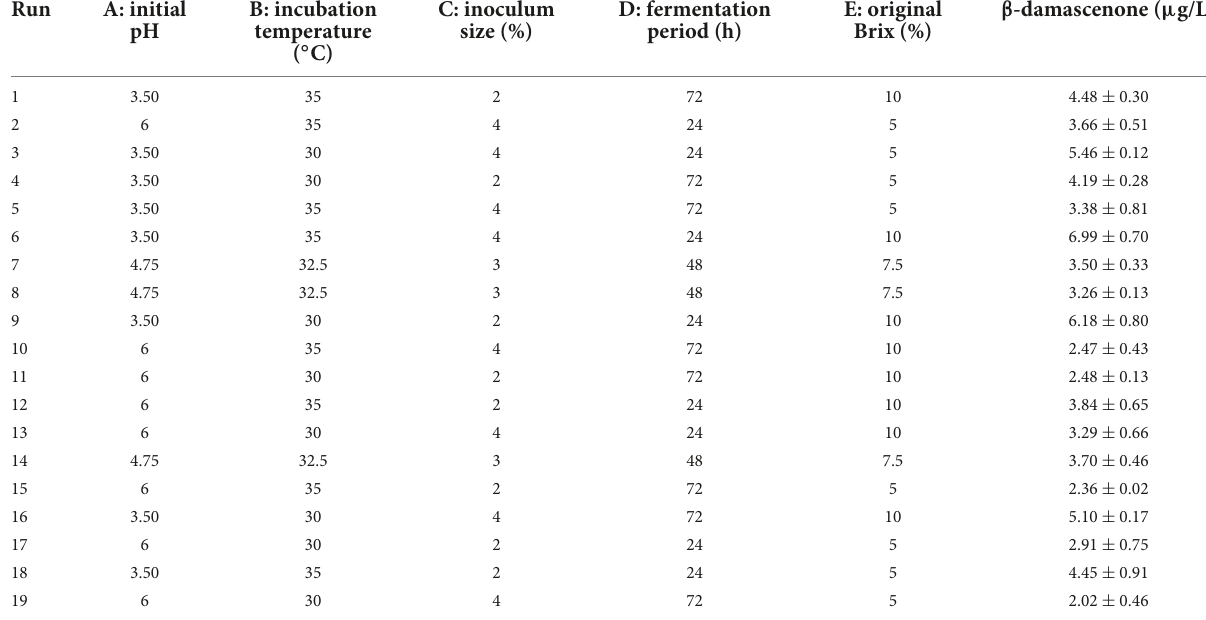
TABLE 2 Plackett-Burman (PB) design experiments for screening the significant independent variables for the yield of β -damascenone from Wickerhamomyces anomalus YWB-1.